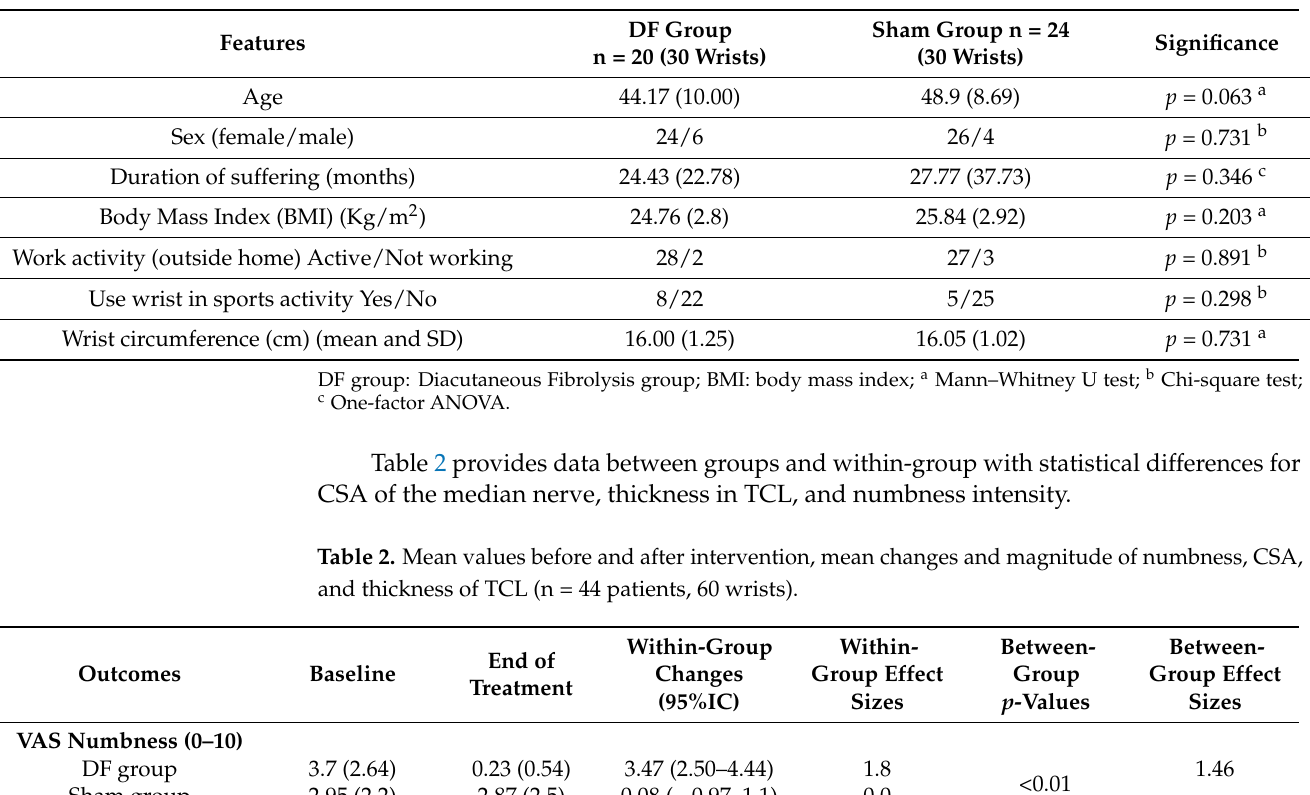
Table 1. Between-groups comparisons at baseline (n = 44 patients, 60 wrists).